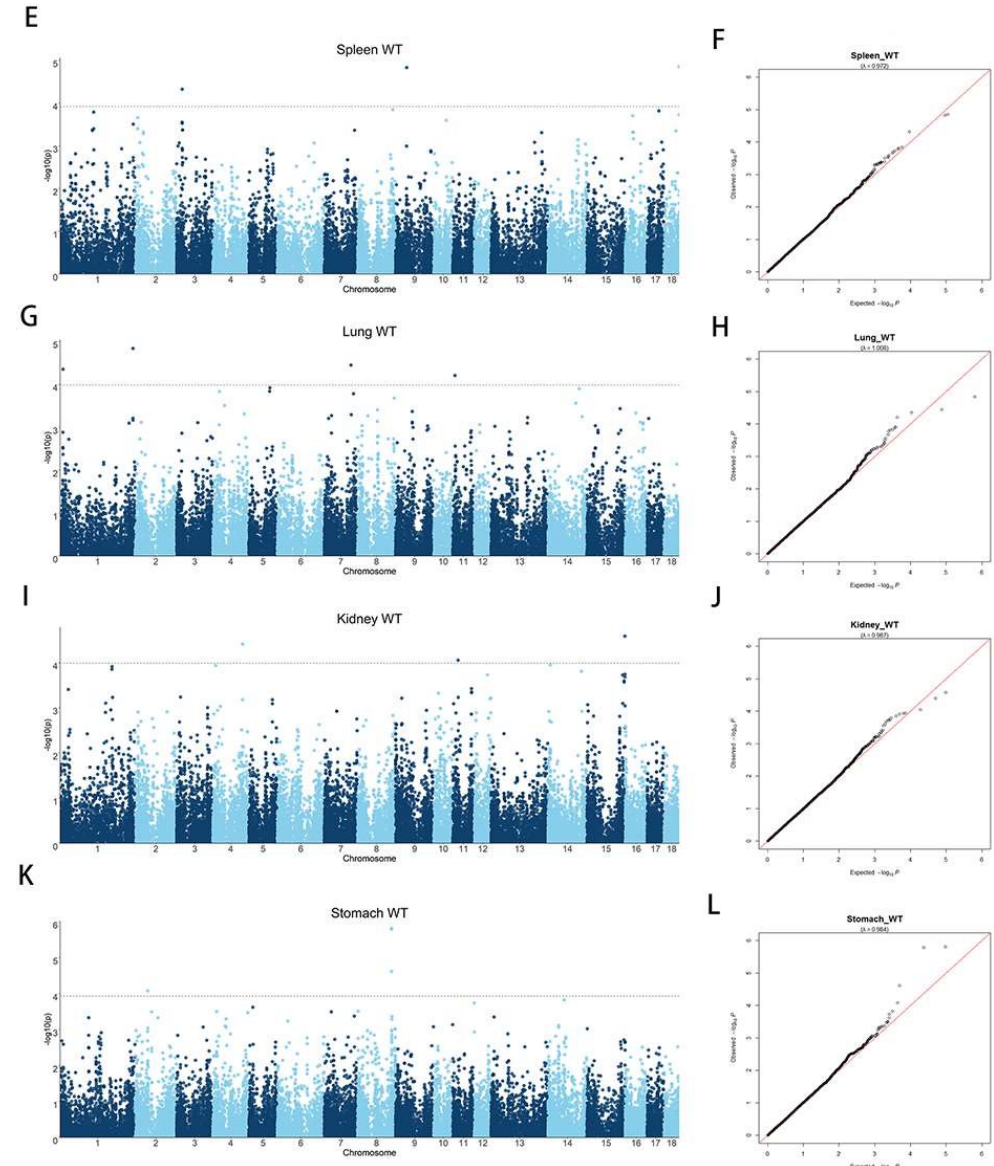
Figure 2. Manhattan and Q–Q plots of internal organ weight traits in the single-trait GWAS. ( A ) GWAS for Heart WT; ( B ) Q–Q plot for Heart WT; ( C ) GWAS for Liver WT; ( D ) Q–Q plot for Liver WT; ( E ) GWAS for Spleen WT; ( F ) Q–Q plot for Spleen WT; ( G ) GWAS for Lung WT; ( H ) Q–Q plot for Lung WT; ( I ) GWAS for Kidney WT; ( J ) Q–Q plot for Heart WT; ( K ) GWAS for Stomach WT; ( L ) Q–Q plot for Stomach WT. The x -axis represents the chromosome, and the y -axis represents the − log10 ( p -value) value in the Manhattan plot of the GWAS. The Q–Q plot is plotted with the x -axis representing the actual measured value of − log10 ( p -value) and the y -axis representing the observed value of − log10 ( p -value) and labeled with the expansion factor lambda ( λ